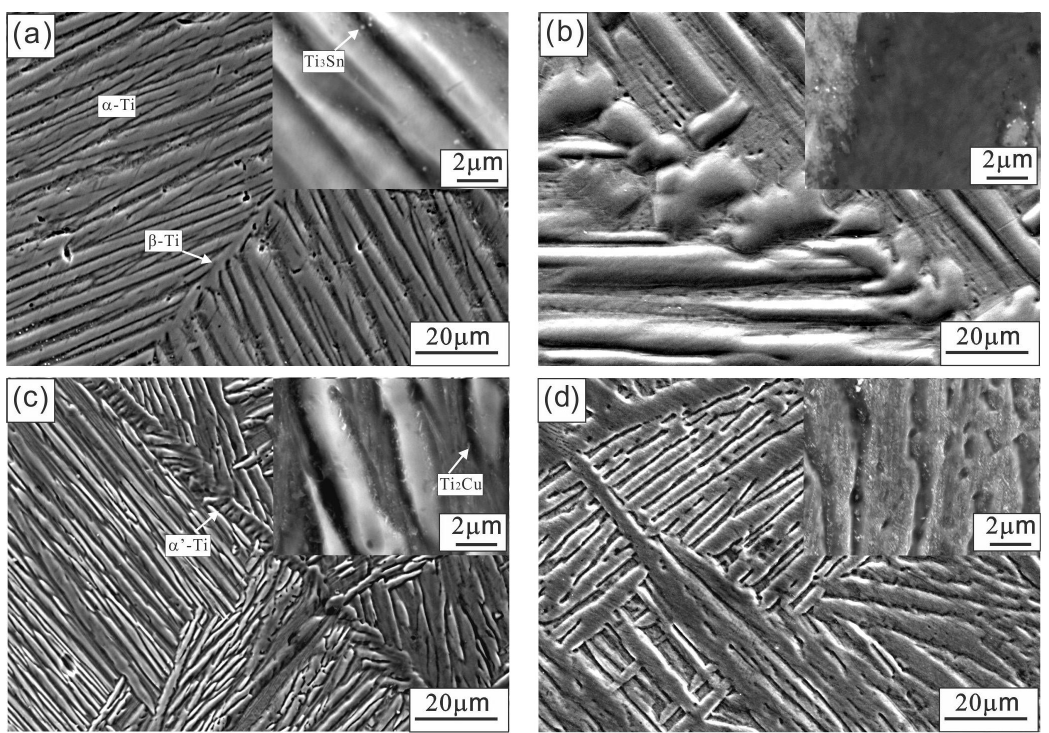
Figure 2. SEM micrograph of Ti15Sn x Cu alloys: (a) AS Ti15Sn, (b) HT Ti15Sn, (c) AS Ti15Sn2Cu and (d) HT Ti15Sn2Cu. The inserts show the high magnification